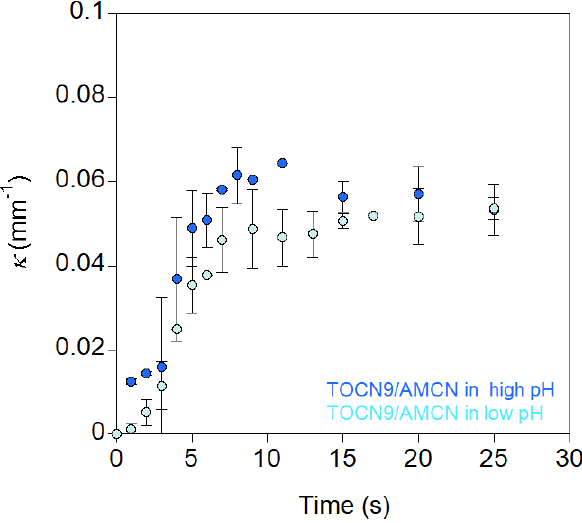
Figure 8. Absolute curvature as a function of time of the TOCN9 / AMCN nanopapers immersed in low or in high pH aqueous solutions (pH 1 and 13, respectively).